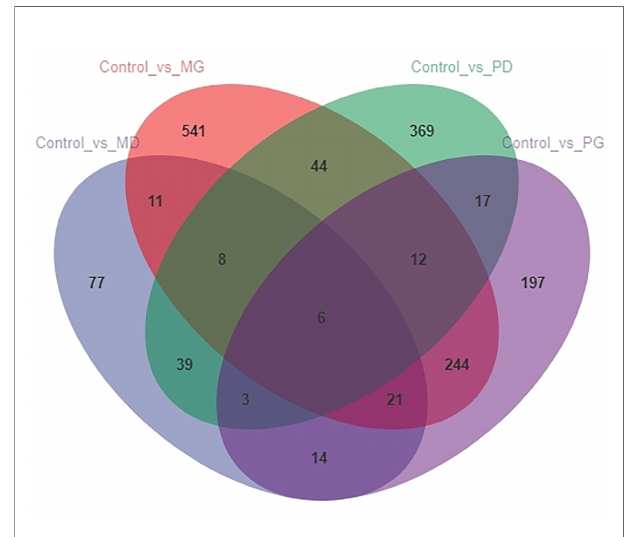
FIGURE 1 | Venn diagram representing the number of differentially expressed genes among different treatment